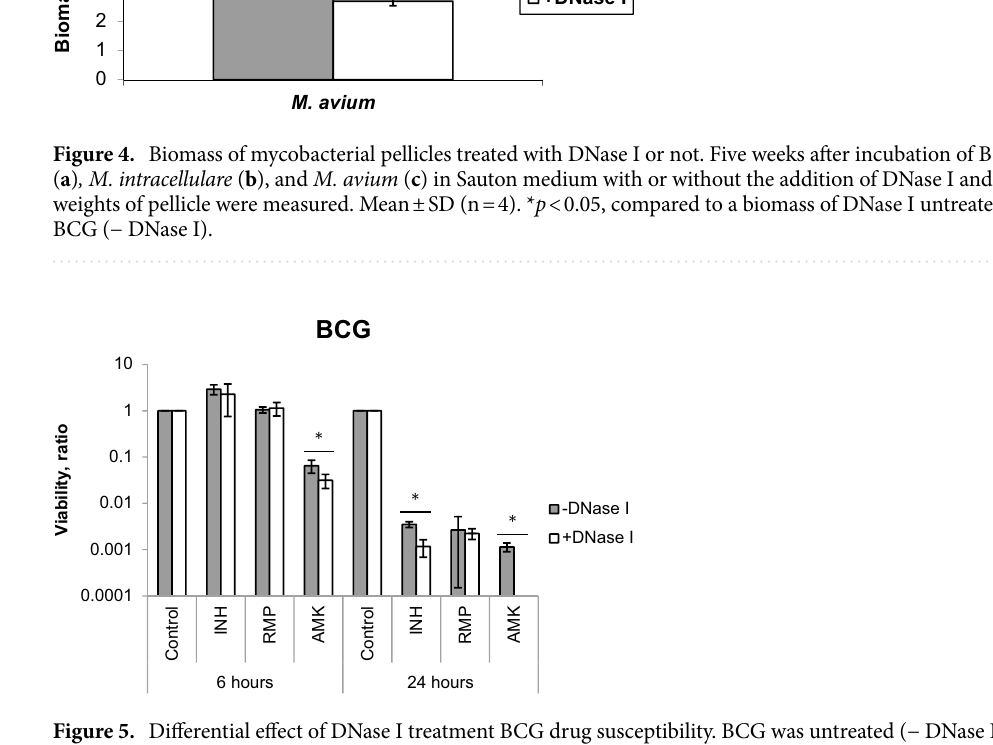
Figure 5. Differential effect of DNase I treatment BCG drug susceptibility. BCG was untreated (− DNase I) or treated (+ DNase I) at 37 °C for 72 h and further incubated with INH, RMP, AMK or not, for 6 and 24 h. CFU/ ml was determined and normalized with that of control samples. The average viability ratio of each sample (mean ± SD, n = 3) is indicated. * p <